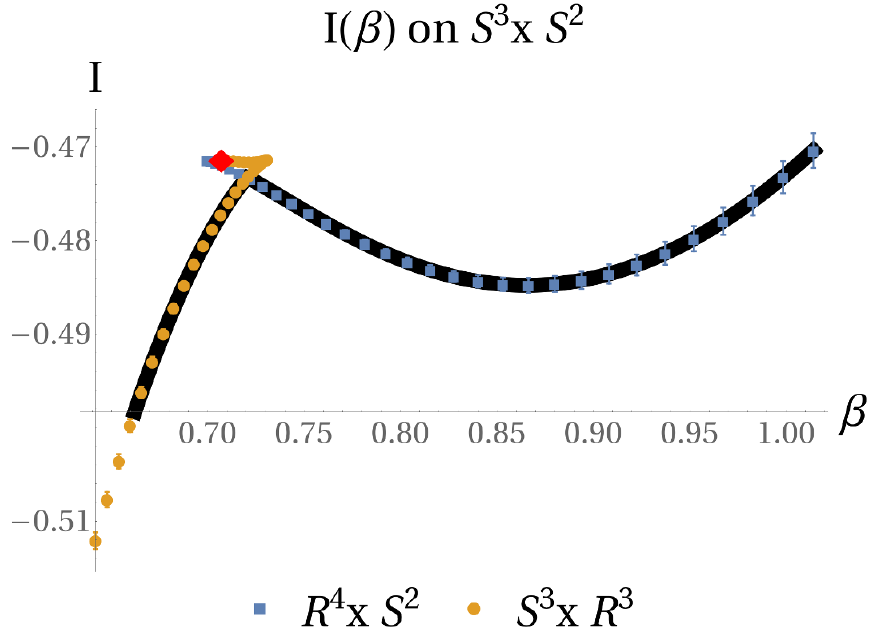
Figure 3 . The action I as a function of the ratio of radii (cid:12) for both topologies with conformal boundary S 3 (cid:2) S 2 . The red diamond is the analytical calculation for the singular ratio (cid:12) s = 0 : 707, and the black line follows the dominant solution for each ratio (cid:12) . We see that there is a (cid:12)rst order phase transition at (cid:12) c = 0 : 720.